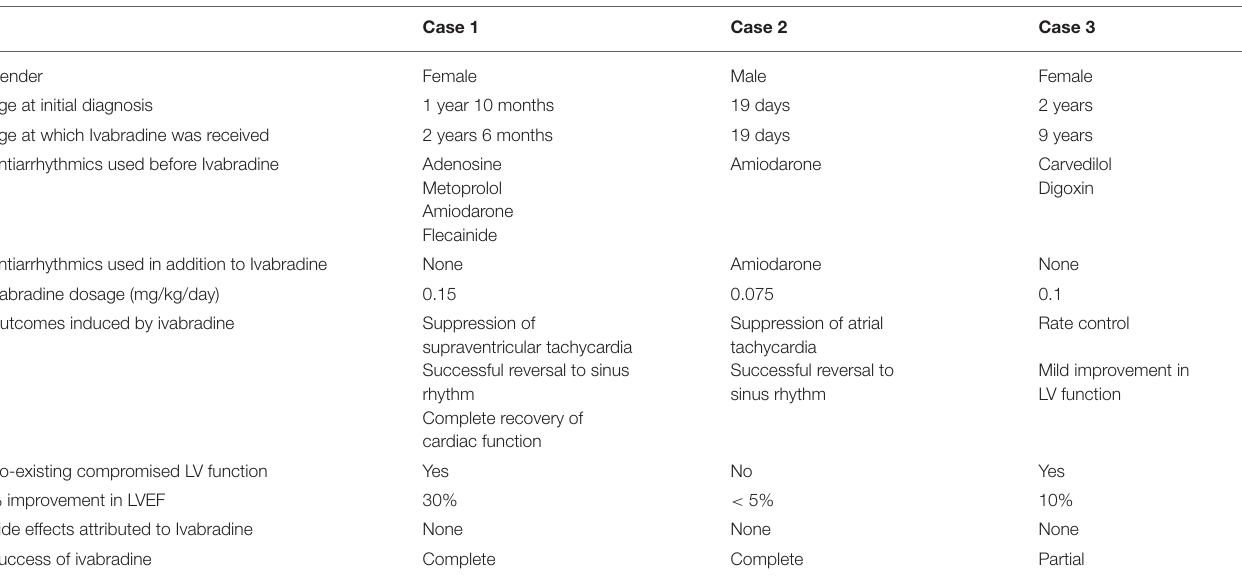
TABLE 3 | Patients characteristics and their response to